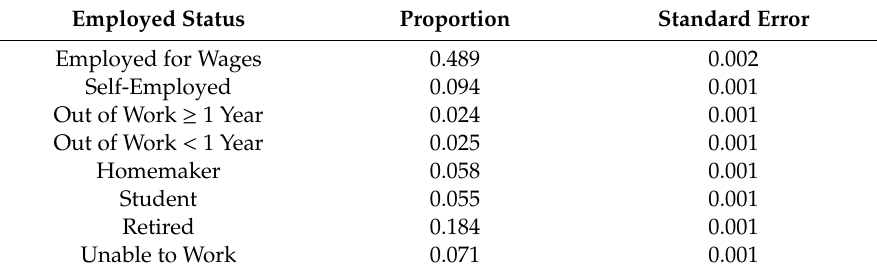
Table 3. Variable EMPLOY1: “Are you currently ... ?